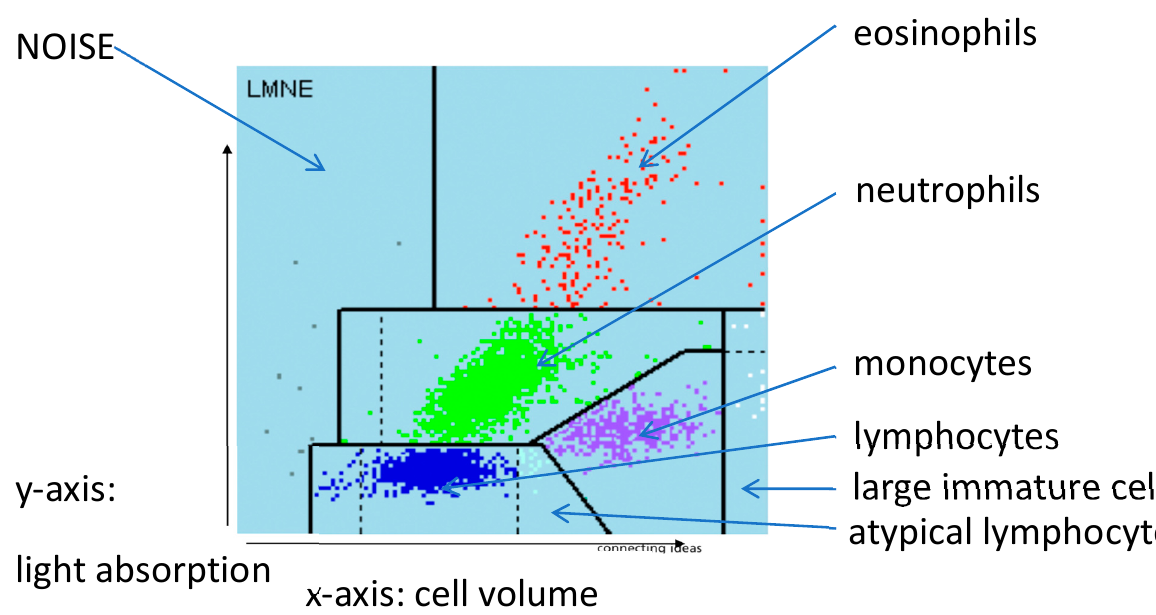
Figure 1. LMNE matrix with the different fields for the leukocyte populations and the NOISE